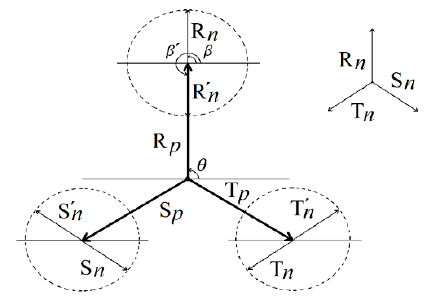
Figure 4. Diagram of positive and negative sequence vectors. The positive diagram with an arbitrary angle θ is shown along with two cases for the negative sequence (R n T n S n and R ′ n T ′ n S ′ n ). In the first case β is in phase with θ and in the second case β ′ is in counter-phase with θ .